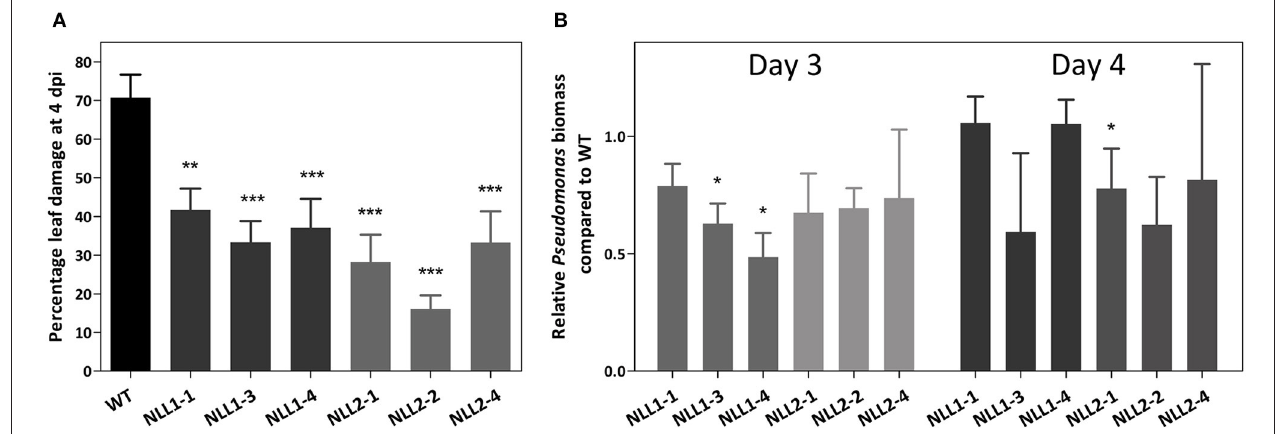
FIGURE 9 | (A) Disease symptoms on wild type and transgenic Arabidopsis lines after infection with Pseudomonas syringae . Percentage leaf damage of infected leaves at 4 dpi was determined in Assess 2.0 and represents two biological replicates. Error bars ± SE, asterisks indicate significant differences compared to the wild type. (B) Relative Pseudomonas biomass in the overexpression lines, compared to the Pseudomonas biomass in wild type plants. Analysis was performed on infected leaves at 3 dpi (left panel–light gray) and 4 dpi (right panel–dark gray). qPCR data were normalized with two Arabidopsis reference genes in REST-384 and represents two biological replicates. Error bars ± SE, asterisks indicate significantly different ratios of the transgenic lines compared to wild type (* p < 0.05, ** p < 0.01, *** p <